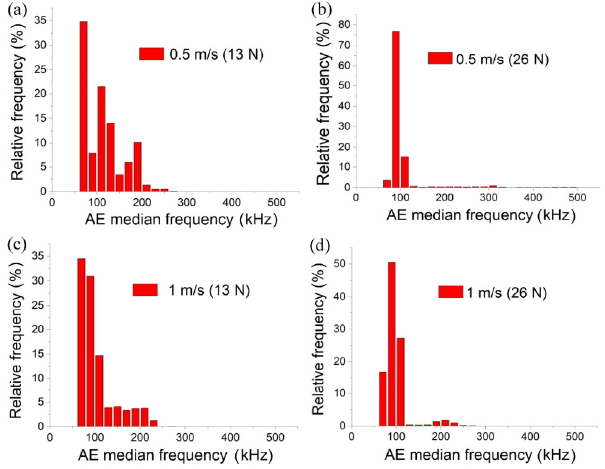
Fig. 7 Median frequency distribution histograms for Y-TZP-Al 2 O 3 .